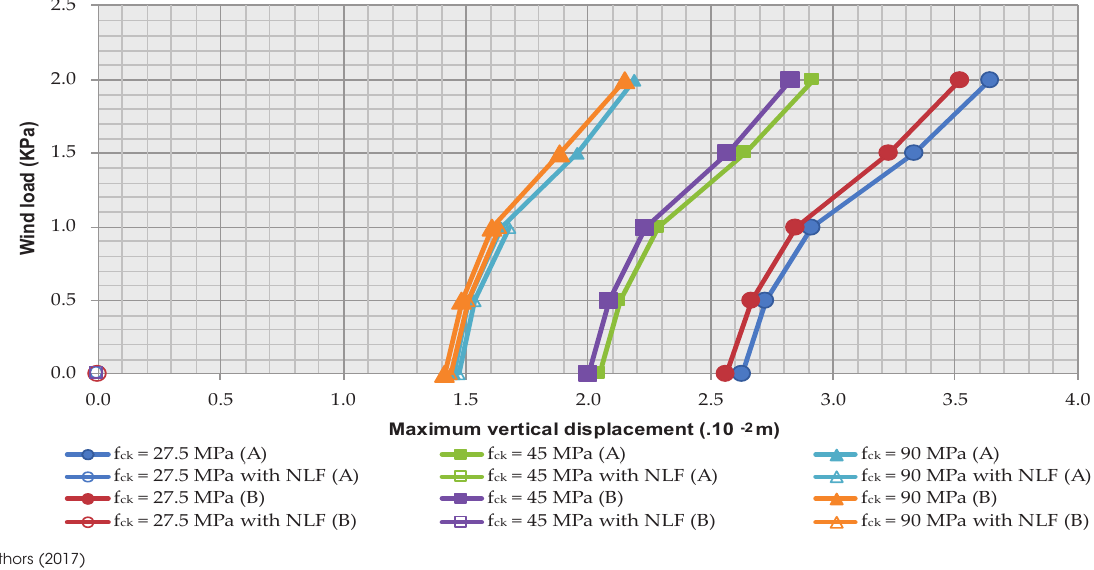
Table 3 and Table 4 and Figure 7 and Figure 8 present the maxi - mum vertical and horizontal displacements obtained on the AASHTO beam Type IV for the four wind pressures analyzed along with the physical and geometrical non-linear analyses. Due to the level of cracking reached in the physical non-linear analyses (PNL) with f equal to 27.5 MPa and 45 MPa, there was no numerical ck convergence and no results were obtained for these strength